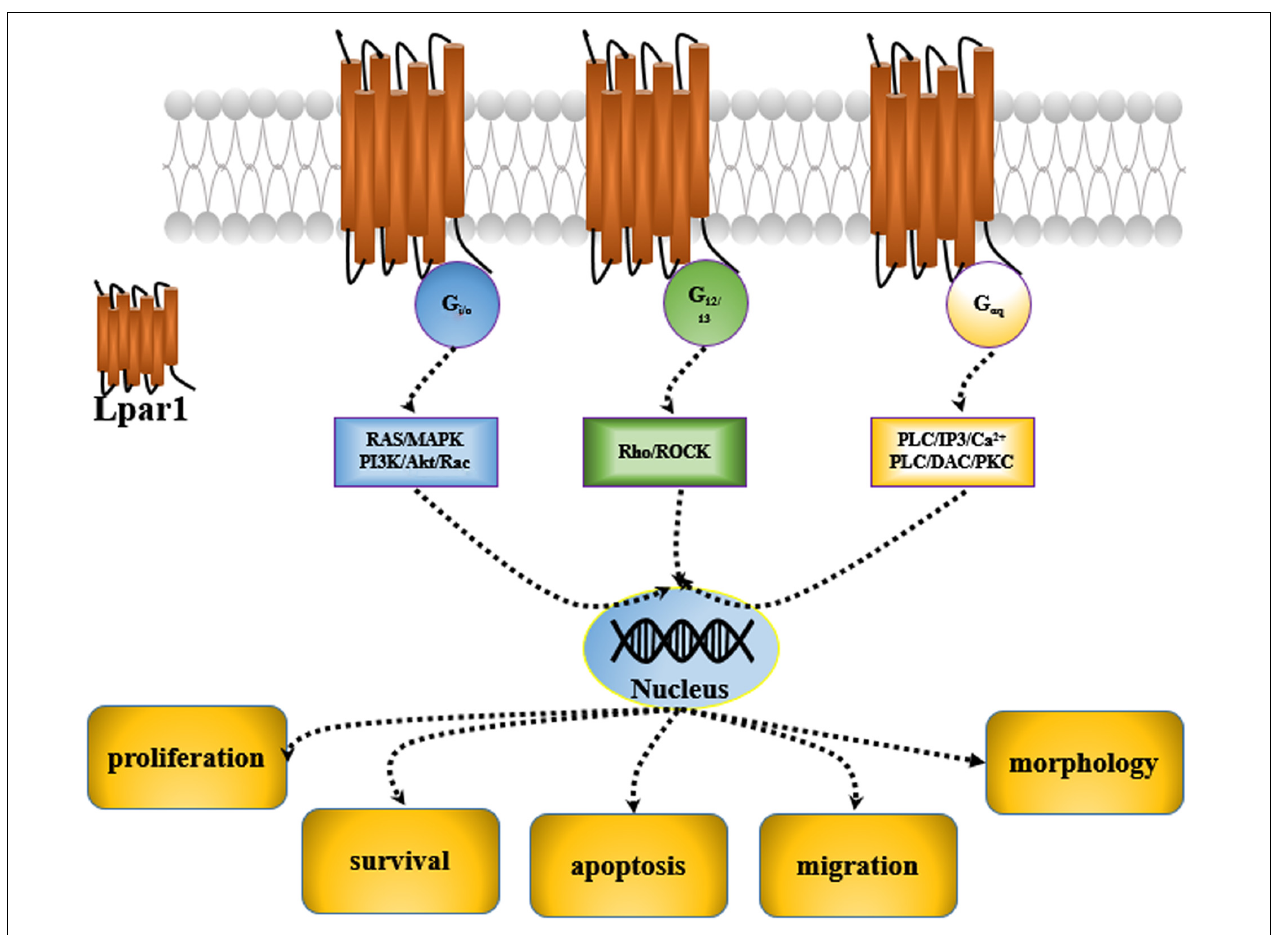
FIGURE 1 | LPA signaling causes G proteins to play different roles in the CNS.